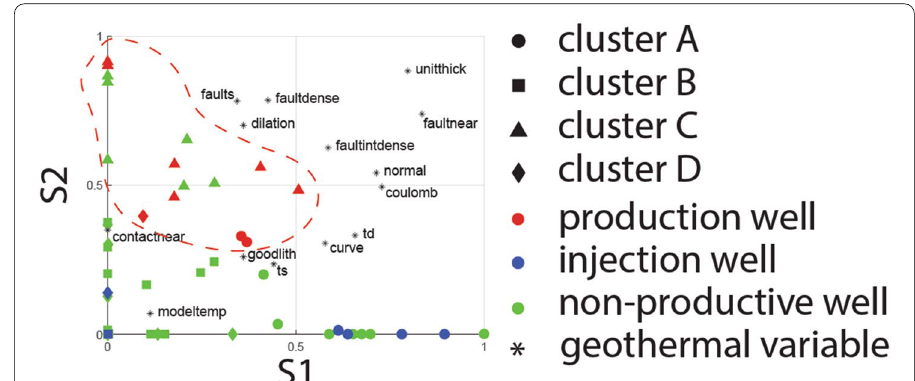
Fig. 6 Biplot of signal-1 (S1) vs signal-2 (S2). Production wells (red) are enclosed by the red dashed polygon. The production wells and the faults, dilation, and faultdense variables have relatively high S2 values